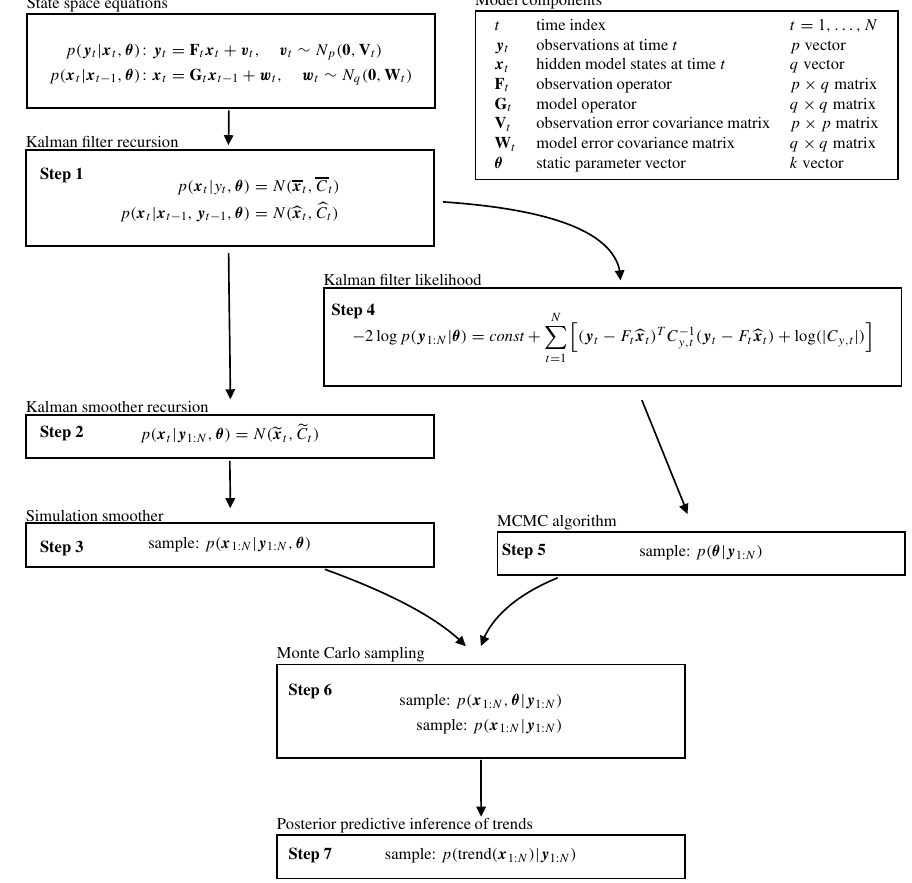
Figure 11. A flowchart showing the dependencies of the DLM calculations explained in Appendix A.